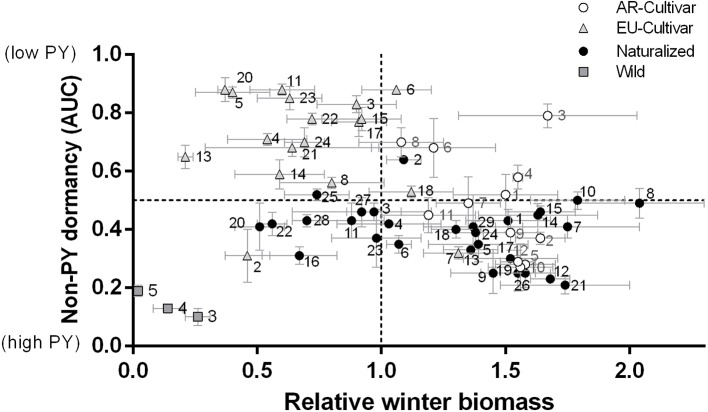
Relationship between relative winter biomass and physical (PY) dormancy [area under the curve (AUC)] for each genotype (mean and standard error) evaluated in common garden during 2014 and 2016. For number references see
Table 1
.